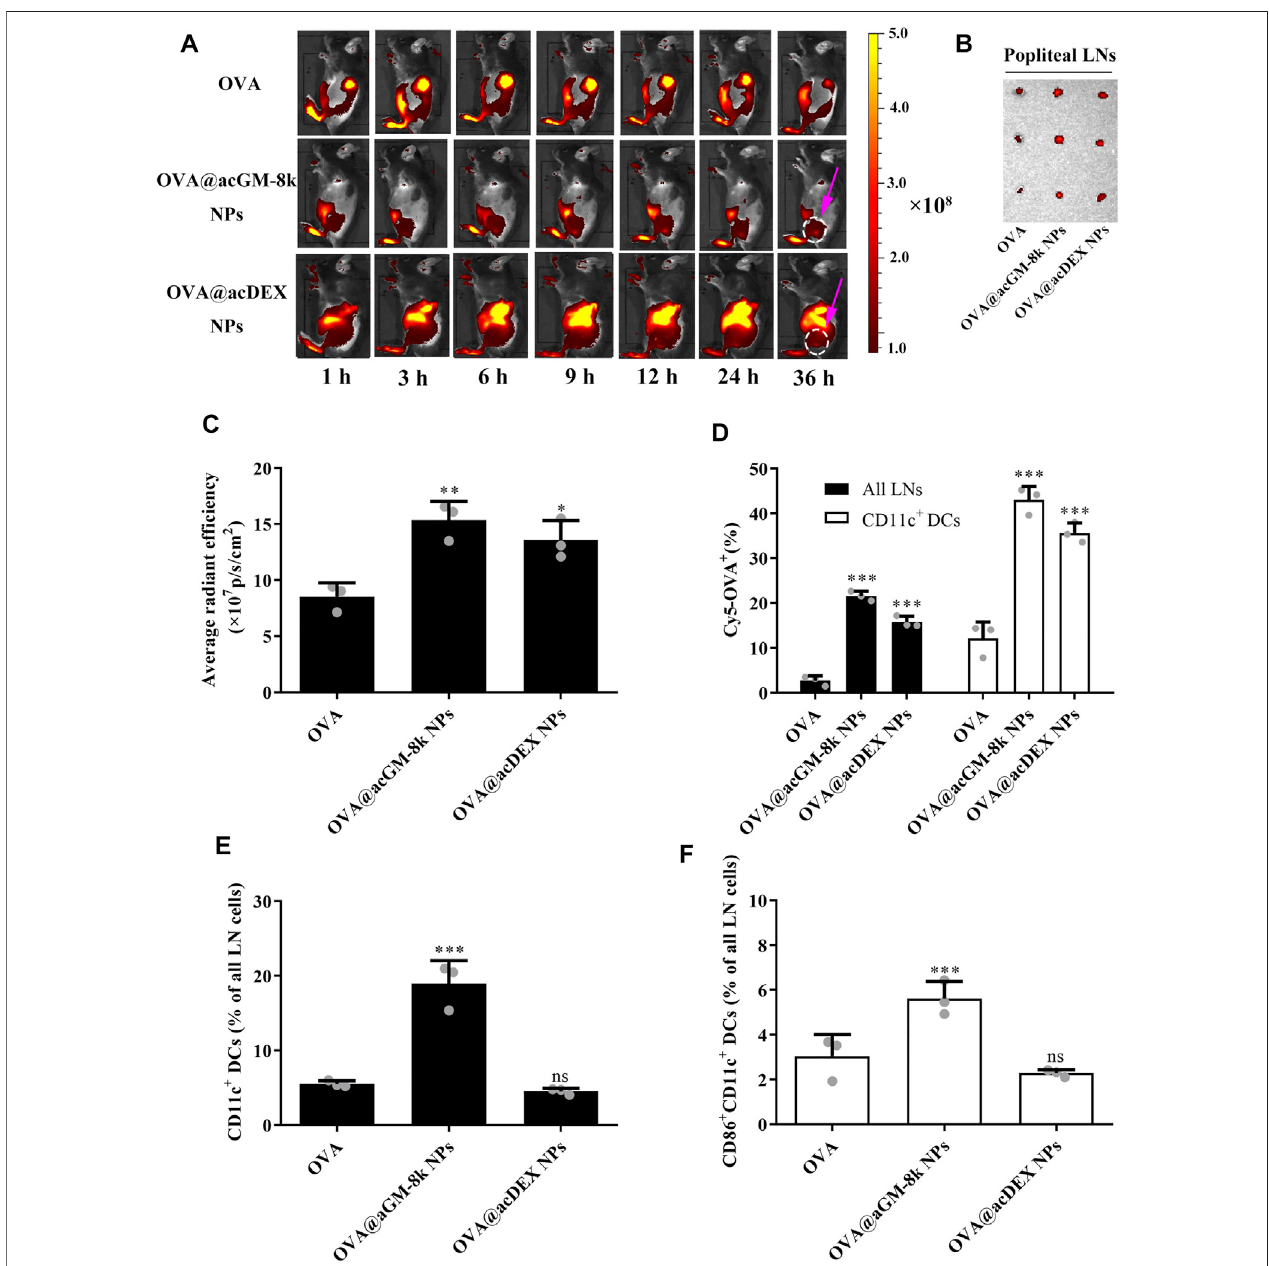
FIGURE 6 | Distribution of OVA@acGM-8k NPs and maturation of lymph node-resident DC in vivo . (A) Migration of OVA@acGM-8k NPs from the injection site to popliteal lymph nodes (LNs) in vivo . The pink arrow indicates the poplitealLNs. (B) Popliteal LNs were isolated and visualized at 36 h after footpad injection. (C) Average radiant ef fi ciency of popliteal LNs at 36 h after footpad injection. (D) The percentages of Cy5-positive in all LNs and CD11c + DCs 36 h after footpad injection. (E) The percentageCD11c + DCsin LNs72 h after immunization. (F) The percentage ofCD86 + inCD11c + DCs inLNs 72 h after immunization.* p < 0.05, ** p < 0.01;*** p < 0.001 vs the OVA group; ns: no signi fi cance; n = 3: For (B) – (F) , data were obtained from three mice in each group. All numerical values are given as average values ± standard deviation. Statistical analysis was performed using Prism Software (GraphPad, United States), followed by one-way ANOVA analysis with Dunnett ’ s post hoc